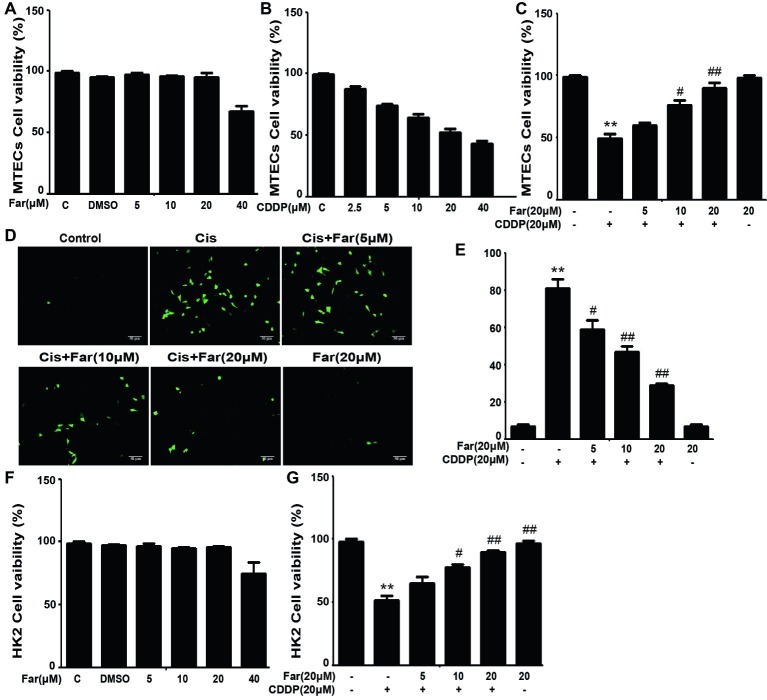
Farrerol affects cisplatin-induced oxidative stress by inhibiting ROS production in vitro. MTECs were treated with the specified concentration of farrerol (A) or cisplatin (B) for 18 h, and the cell viability was then determined through the CCK-8 assay. (C) MTECs were treated with various concentrations of farrerol (5, 10 and 20 μM) for 1 h and then with cisplatin (20 μM) for 18 h, and the CCK-8 assay was then used for the assessment of cell viability. MTECs were stained with 50 mM ROS fluorescent probe for 30 min, and the resulting fluorescence was detected using a fluorescence microscope (D) and multiple detection readers (E). (F,G) HK2 cells were treated as in (A) and (C), and the cell viability was measured with the CCK-8 assay. All of the data displayed represent the mean of three independent experiments. *p < 0.05 and **p < 0.01 vs. the control group; #p < 0.05 and ##p < 0.01 vs. the CDDP group.